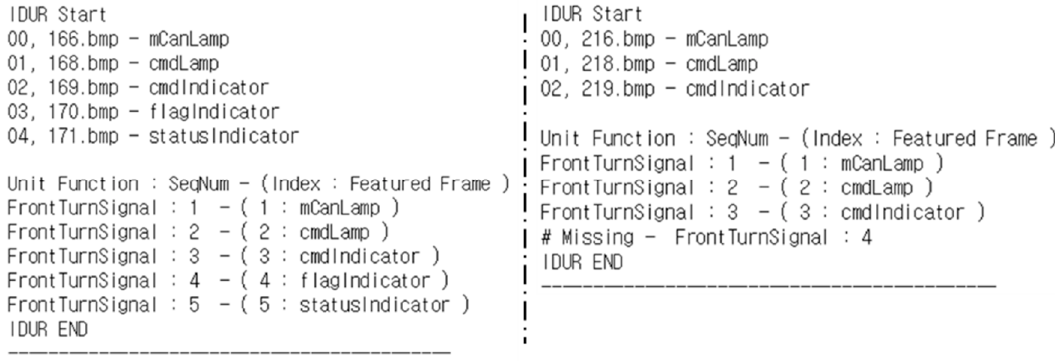
Figure 12. Finding the fault-occurrence point of fault index #1.